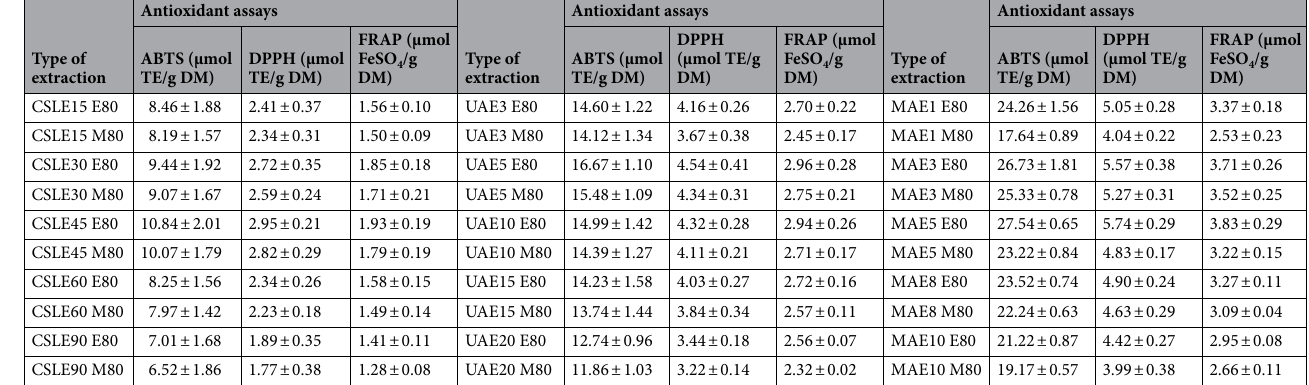
Table 2. Antioxidant activities of distillery stillage extracts obtained with 80%